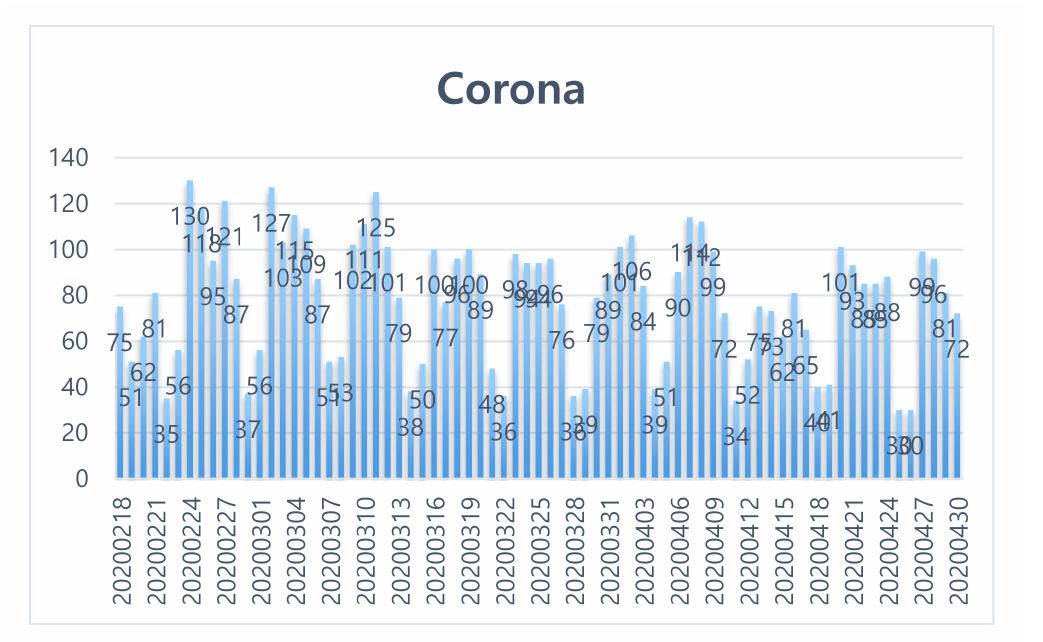
Figure 4. Keyword trends (active response stage: February 17 2020~30 April